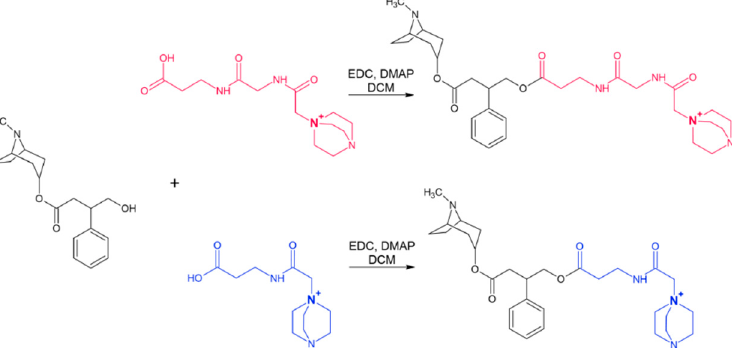
Figure 13. Scheme of derivatization reactions of atropine (DCM, dichloromethane; DMAP, 4- dimethylaminopyridin; EDC, 1-ethyl-3-(3-dimethylaminopropyl)carbodiimide).